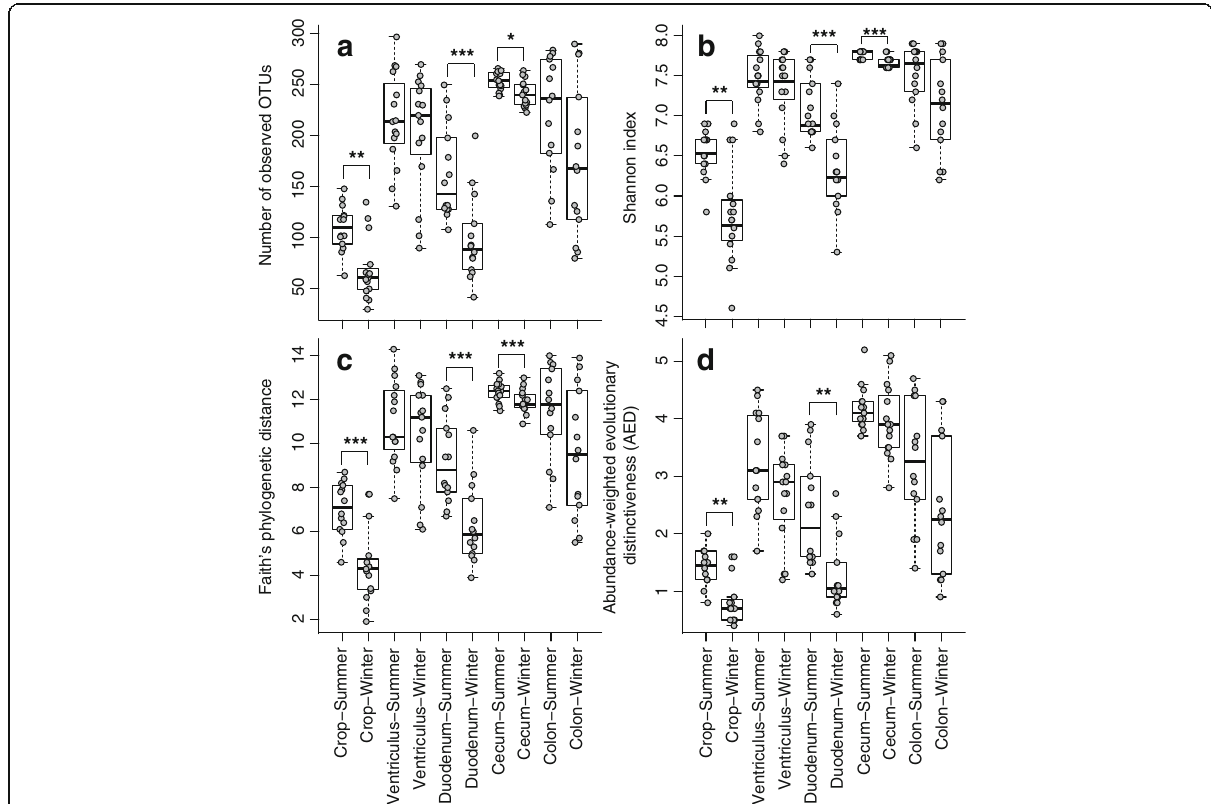
Fig. 4 Box plots of microbiota α -diversity indexes for gut regions by season: ( a ) richness (number of observed OTUs), ( b ) abundance and evenness (Shannon index), ( c ) minimum total length of all phylogenetic branches in the community (Faith ’ s Phylogenetic Diversity index), ( d ) abundance- weighted evolutionary distinctiveness (AED). Wilcoxon Signed Rank test P -values identified as follows: *** P ≤ 0.001, ** 0.001< P ≤ 0.01, * 0.01< P ≤